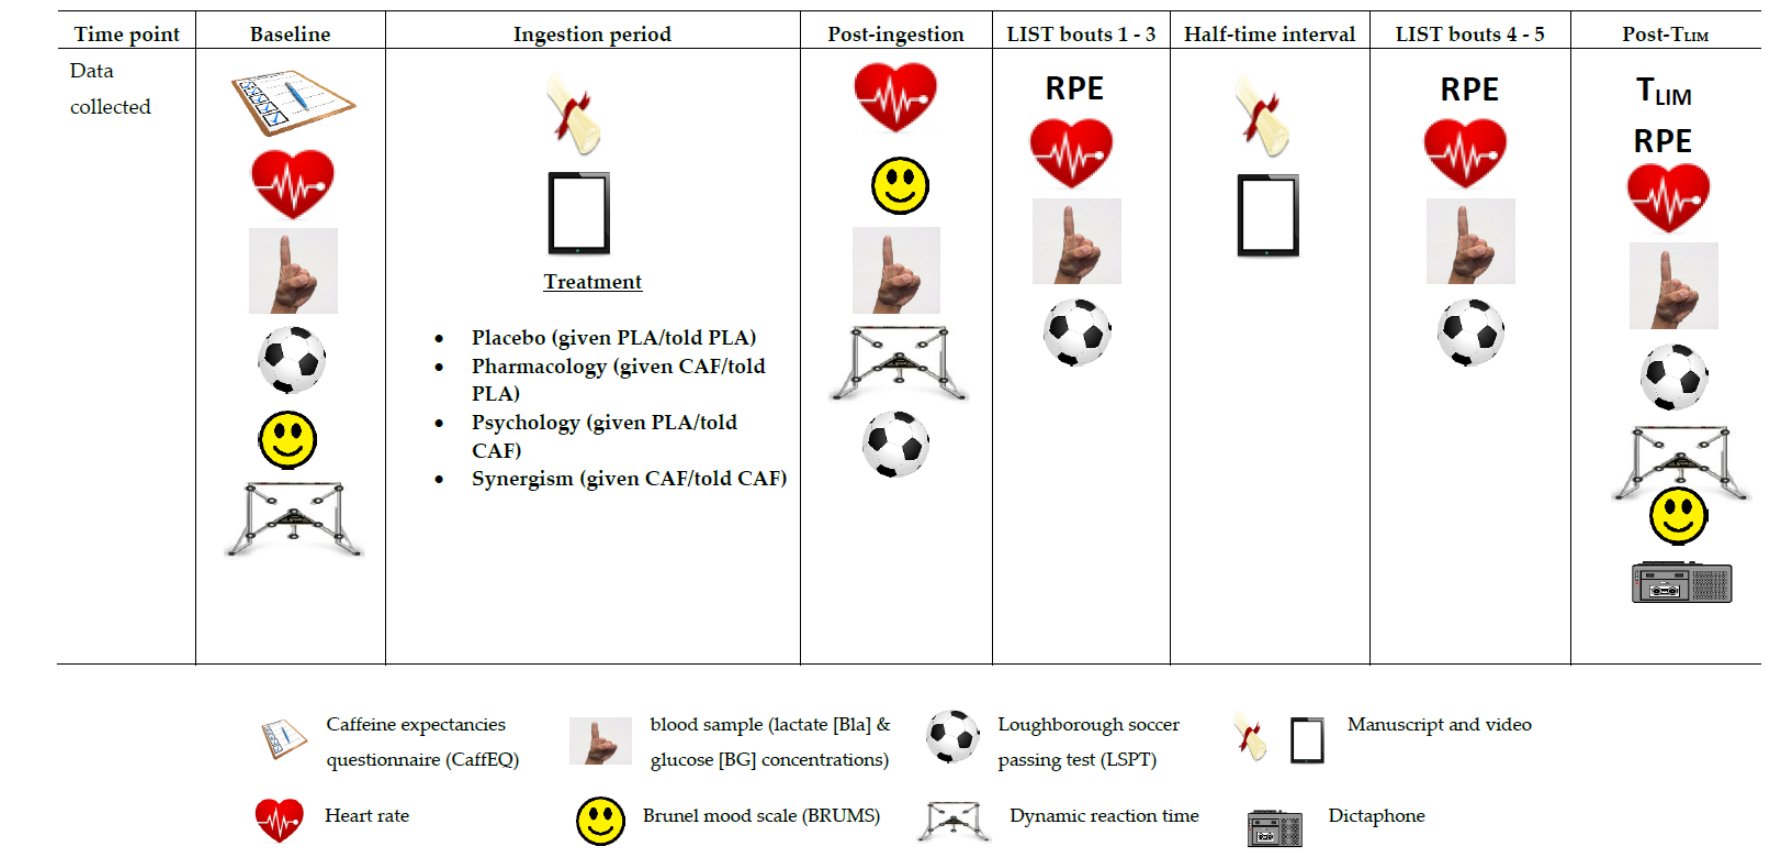
Figure 1. Experimental protocol outline for trials 2–6. Legend (N.B: Caffeine expectancies questionnaire (CaffEQ) and Dictaphone only utilised during trials 2, 3 and 5 and trials 4 and 6, respectively). (PLA = placebo; CAF = caffeine; RPE = ratings of perceived exertion [43]; LIST = Loughborough Intermittent Shuttle Test; CaffEQ = caffeine expectancies questionnaire [50].